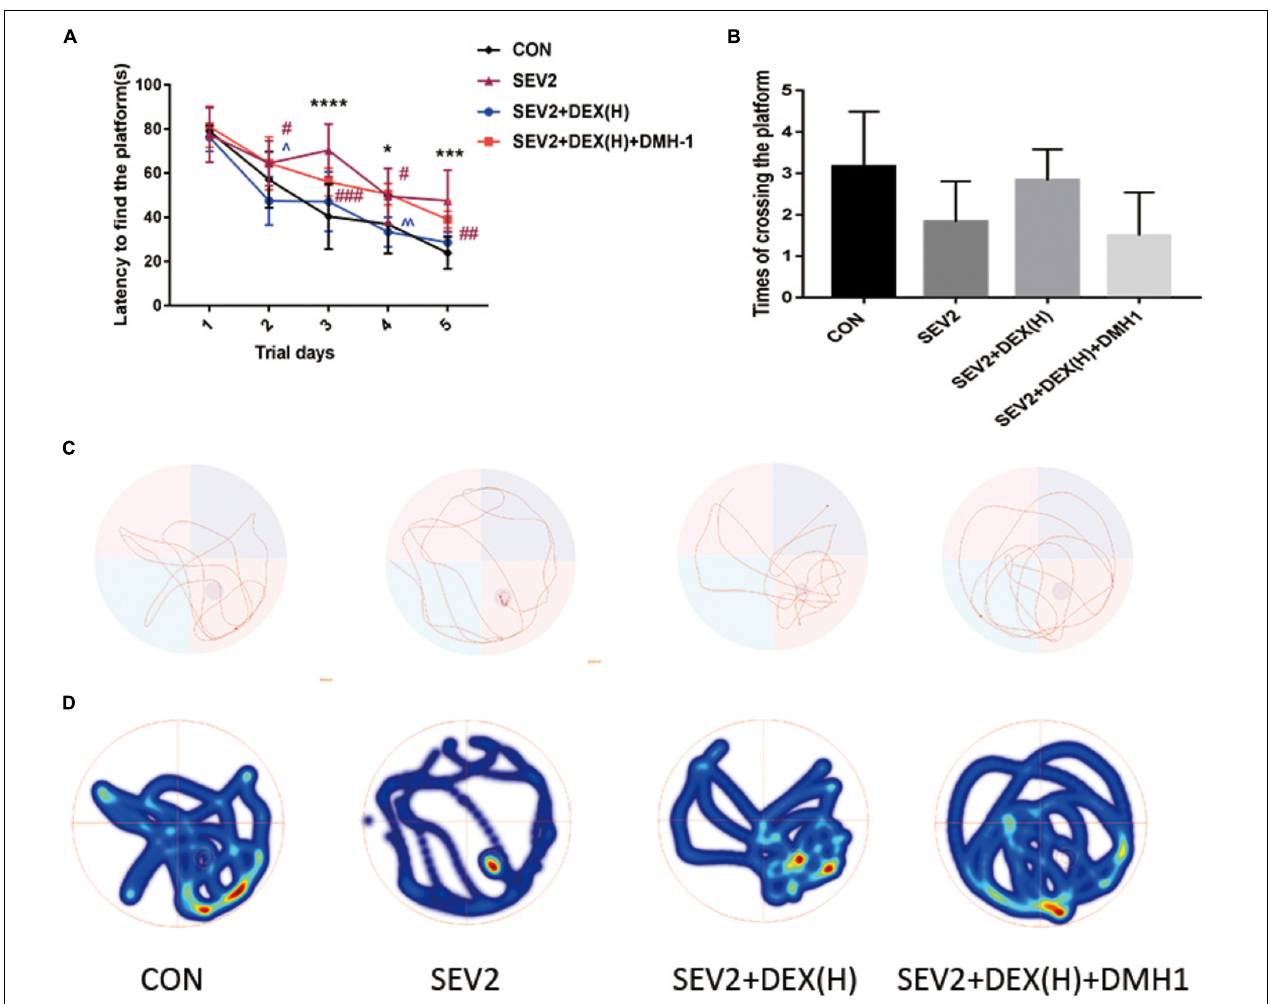
FIGURE 8 | Cognitive dysfunction improvement induced by Dex on juvenile offspring was repressed by DMH1. Escape latency (A) and platform crossing times (B) in each group. Two-way ANOVA with repeated measurement analysis was followed by Bonferroni’s post hoc test to analyze the escape latency, and times of crossing platform were analyzed using Kruskal–Wallis with Dunn’s Multiple comparison test. Data are expressed as the means ± SEM ( n = 8 in each group); ∗ P < 0.05, ∗∗∗ P < 0.001, ∗∗∗∗ P < 0.0001 compared to the CON group; # P < 0.05, ## P < 0.01, ### P < 0.001, compared to the SEV2 group; ∧ P < 0.05, ∧∧ P < 0.01, compared to the SEV2+DEX(H) group. Typical swimming patterns (C) and heat maps (D) showed the swimming path of the offspring on the 6th day of the MWM